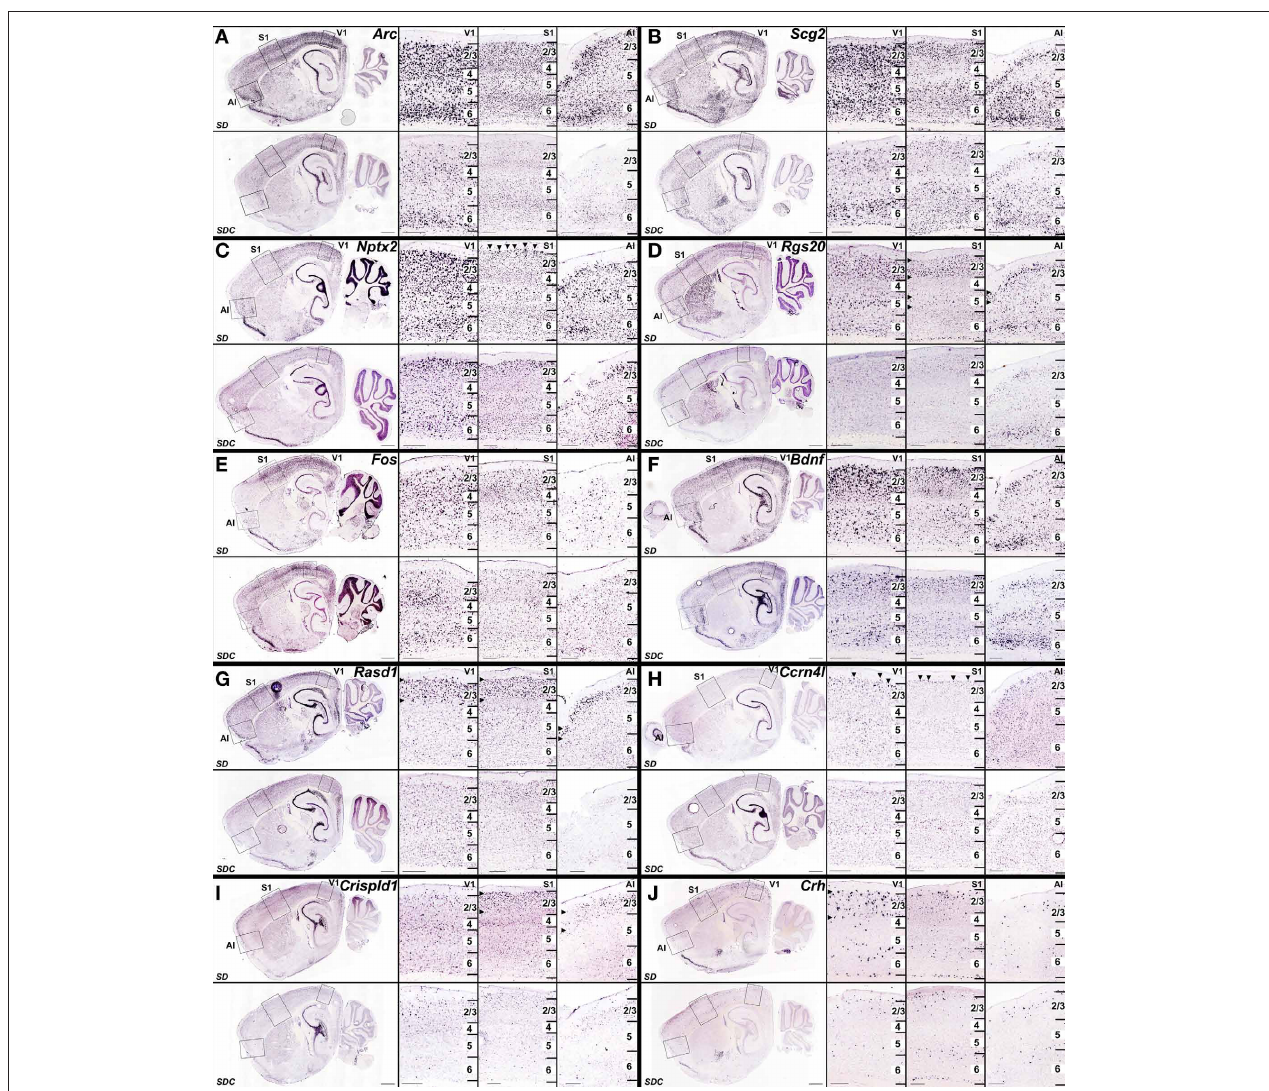
gene, from broad upregulation in all three regions in all layers [e.g., Arc (A) , Scg2 (B) ], to increasingly layer- and region-specific upregulation for Nptx2 (C) , Rgs20 (D) , Fos (e) , Bdnf (F) , Rasd1 (g) , Ccrn4l (H) , Crispld1 (i) , and Crh (J) . Horizontal arrowheads in (D,g,i,J) indicate layer-specific SD induction, and arrowheads in (C) and (H) delineate selective gene induction in neurons at the upper boundary of layer 2. Scale bars: low magnification images, 1 mm; high magnification images, 250